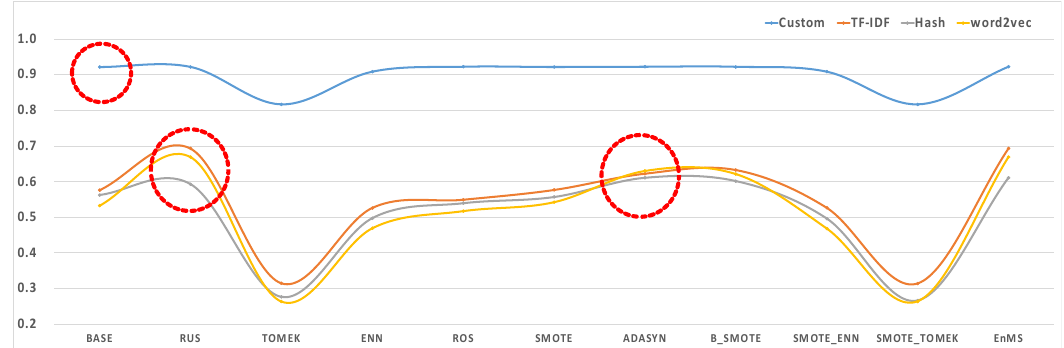
Figure 10. Results of sampling models according to data distribution (algorithm RF, F 1- score , dataset CSIC2012).